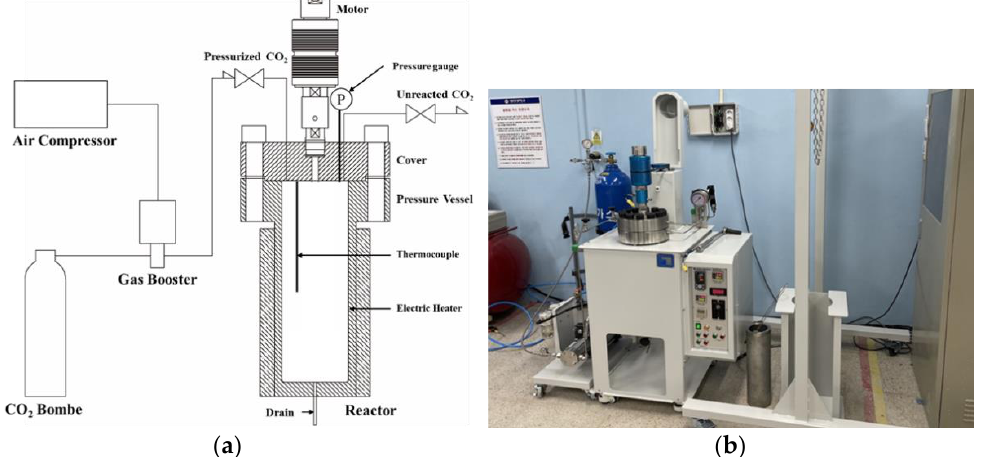
Figure 9. Supercritical carbon dioxide (CO 2 ) reactor. ( a ) Conceptual diagram of the supercritical CO 2 reactor; ( b ) Installation example of the supercritical CO 2 reactor